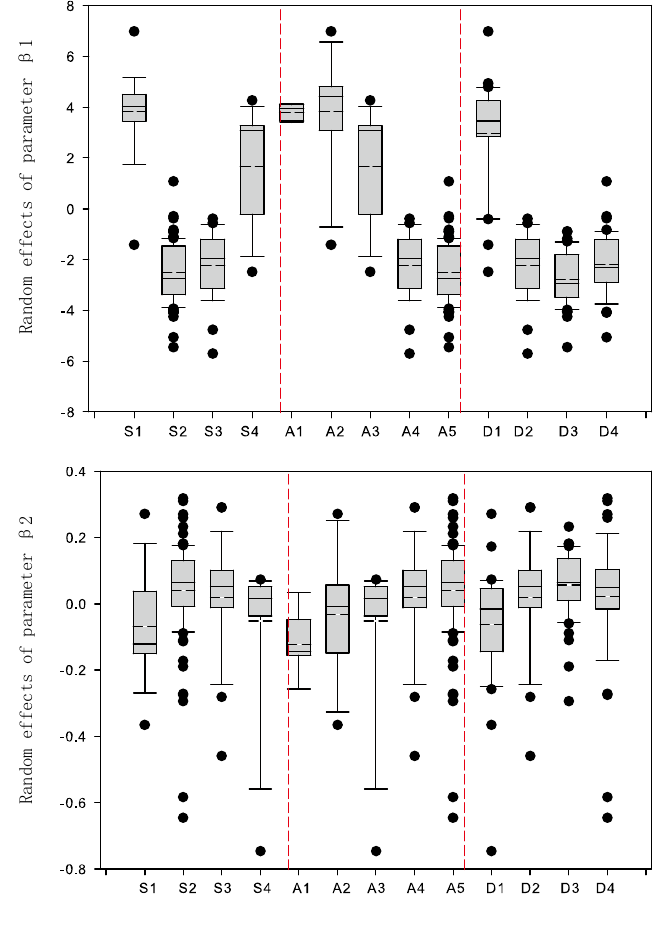
Figure 4. Box- plots of random effects for parameters β 1 and β 2 for the second-order branches by site (S1–S4), age (A1–A5), and density (D1–D4) (dashed line denotes the mean